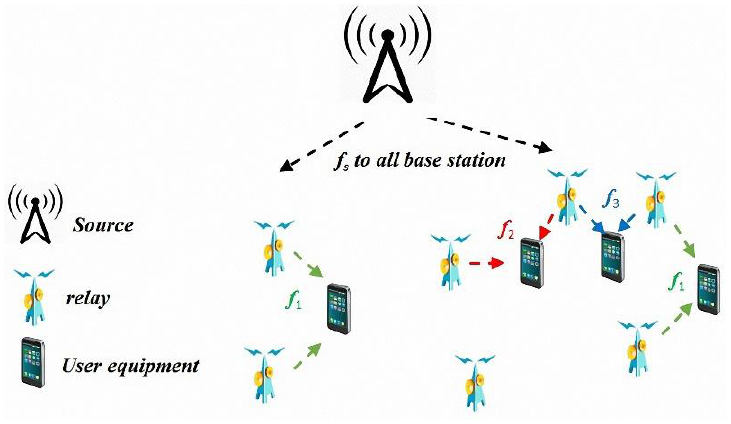
Figure 2. The illustration of the pilot-based grouping method [17].